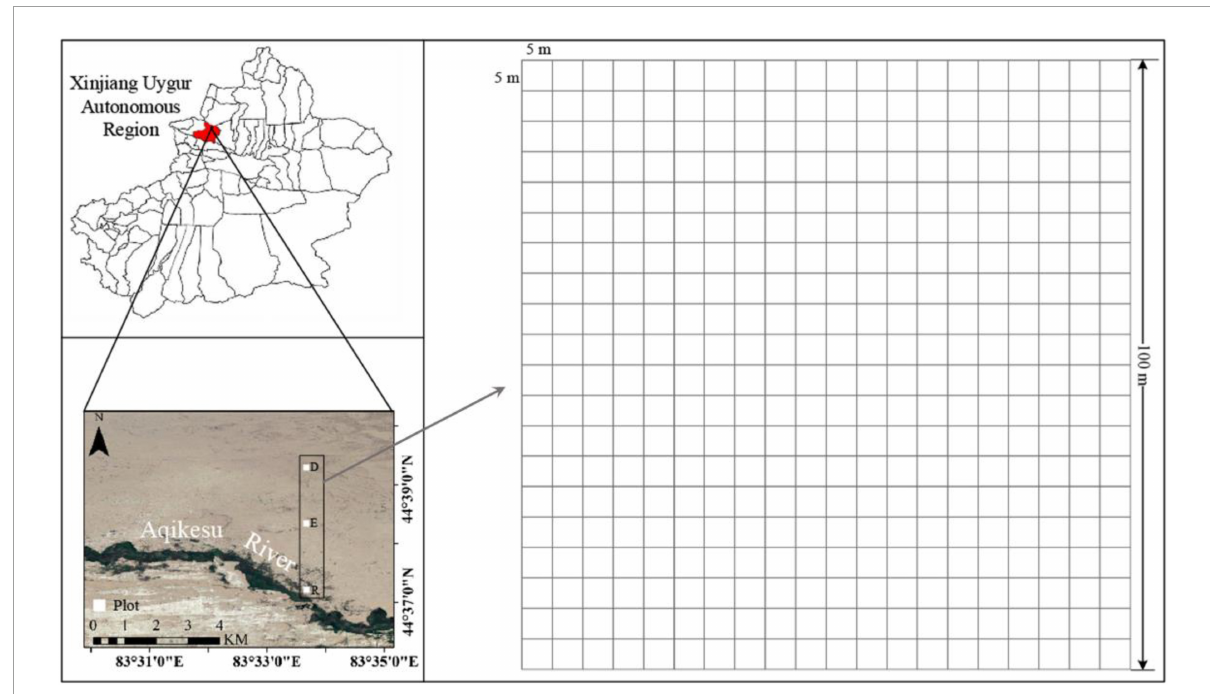
FIGURE1 Study area and location of the sampling plots. R, E, and D represent riparian forest, ecotone community, and desert shrubs, which grow in the river bank, the transitional zone and desert hinterland,